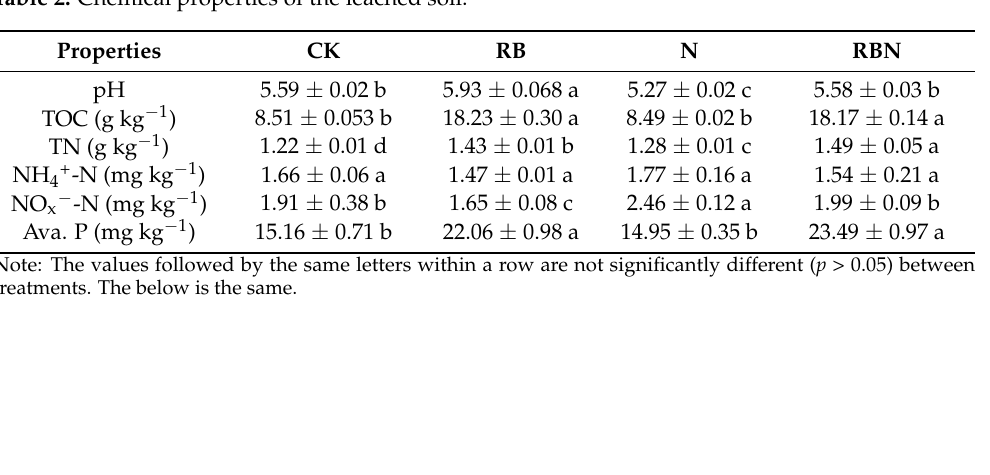
Table 2. Chemical properties of the leached